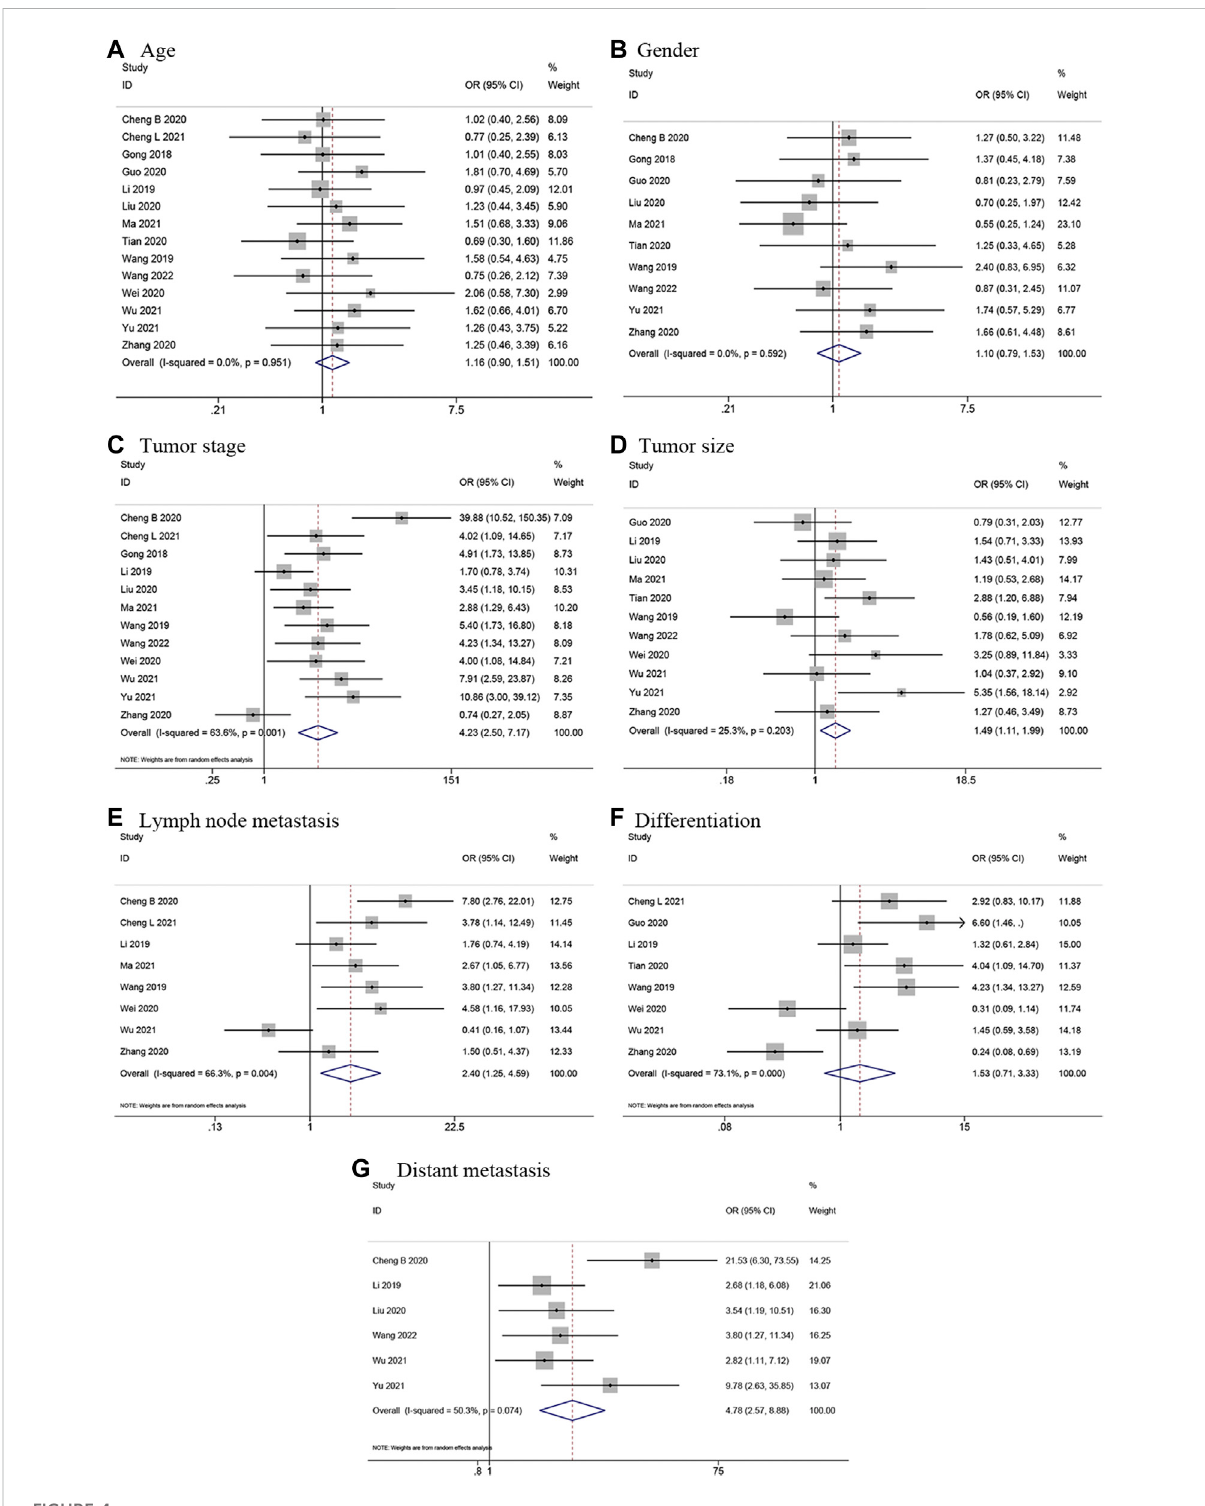
FIGURE 4 ForestplotsforassociationofLINC00662expressionwithclinicopathologicalfeatures. (A) Age. (B) Gender. (C) Tumorstage. (D) Tumorsize. (E) Lymph node metastasis. (F) Differentiation. (G) Distant